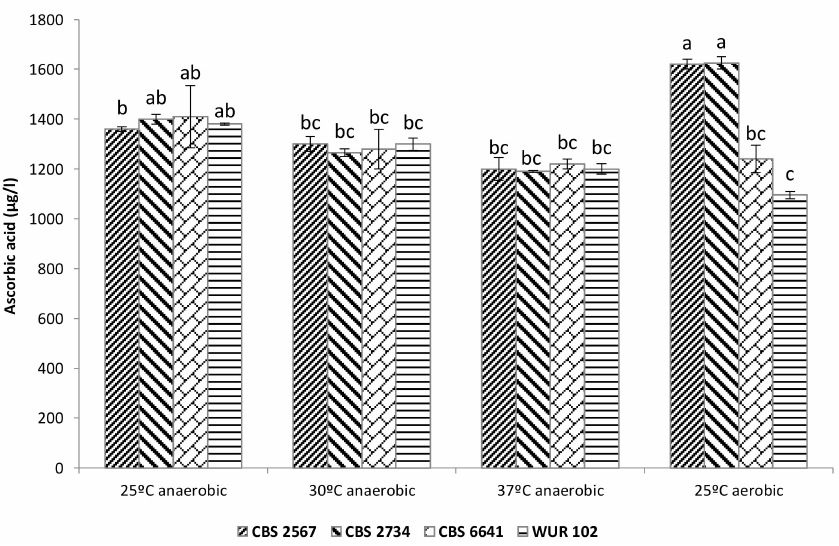
Figure 5. Ascorbic acid content in fermented cashew apple juice employing the selected strains. Letters above bars indicate grouping according to